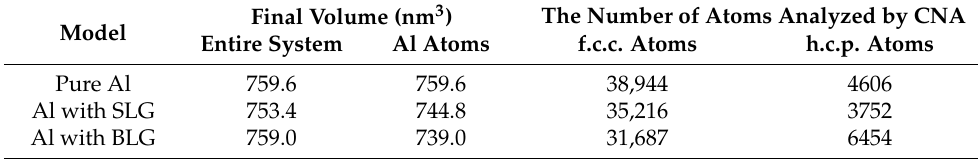
Table 2. Analysis on sintered